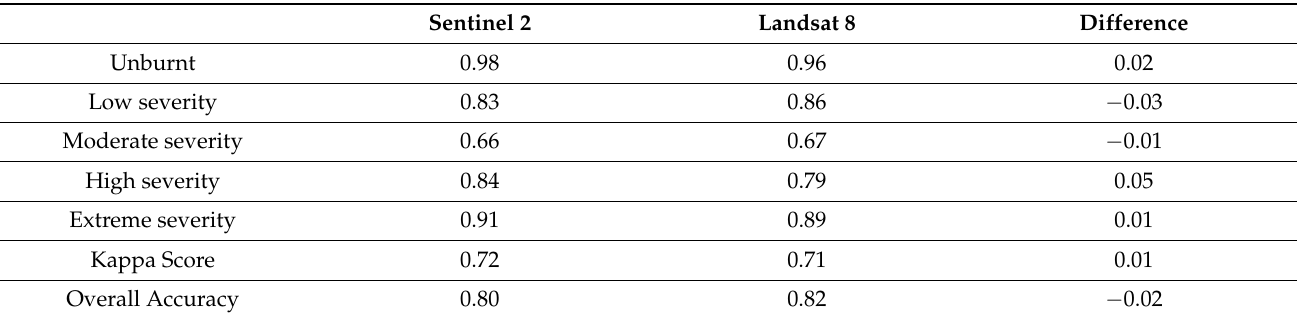
Table 4. Comparison of the balanced accuracy statistics for each severity class, as well as the Kappa and overall balanced accuracy statistics for Sentinel 2 and Landsat 8 FESM algorithms independently tested across the eight training